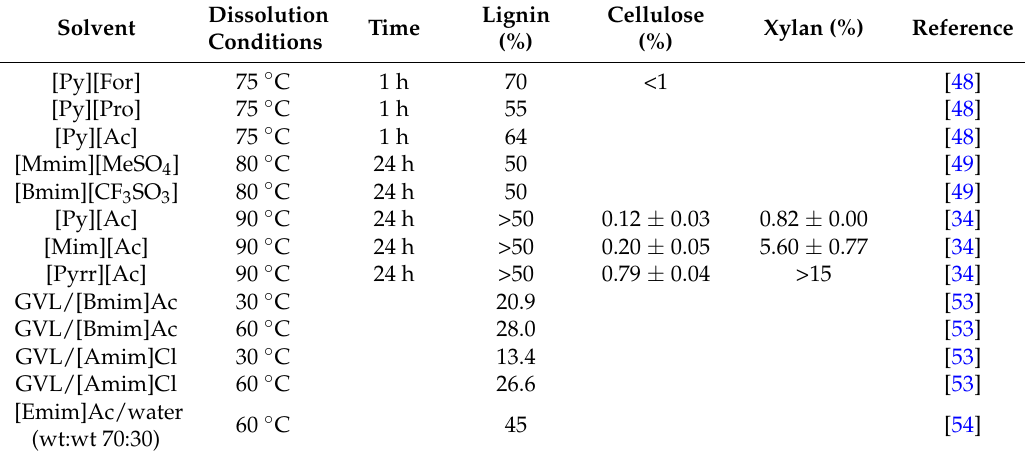
Table 2. Solubility of lignin in ILs and IL-based solvent